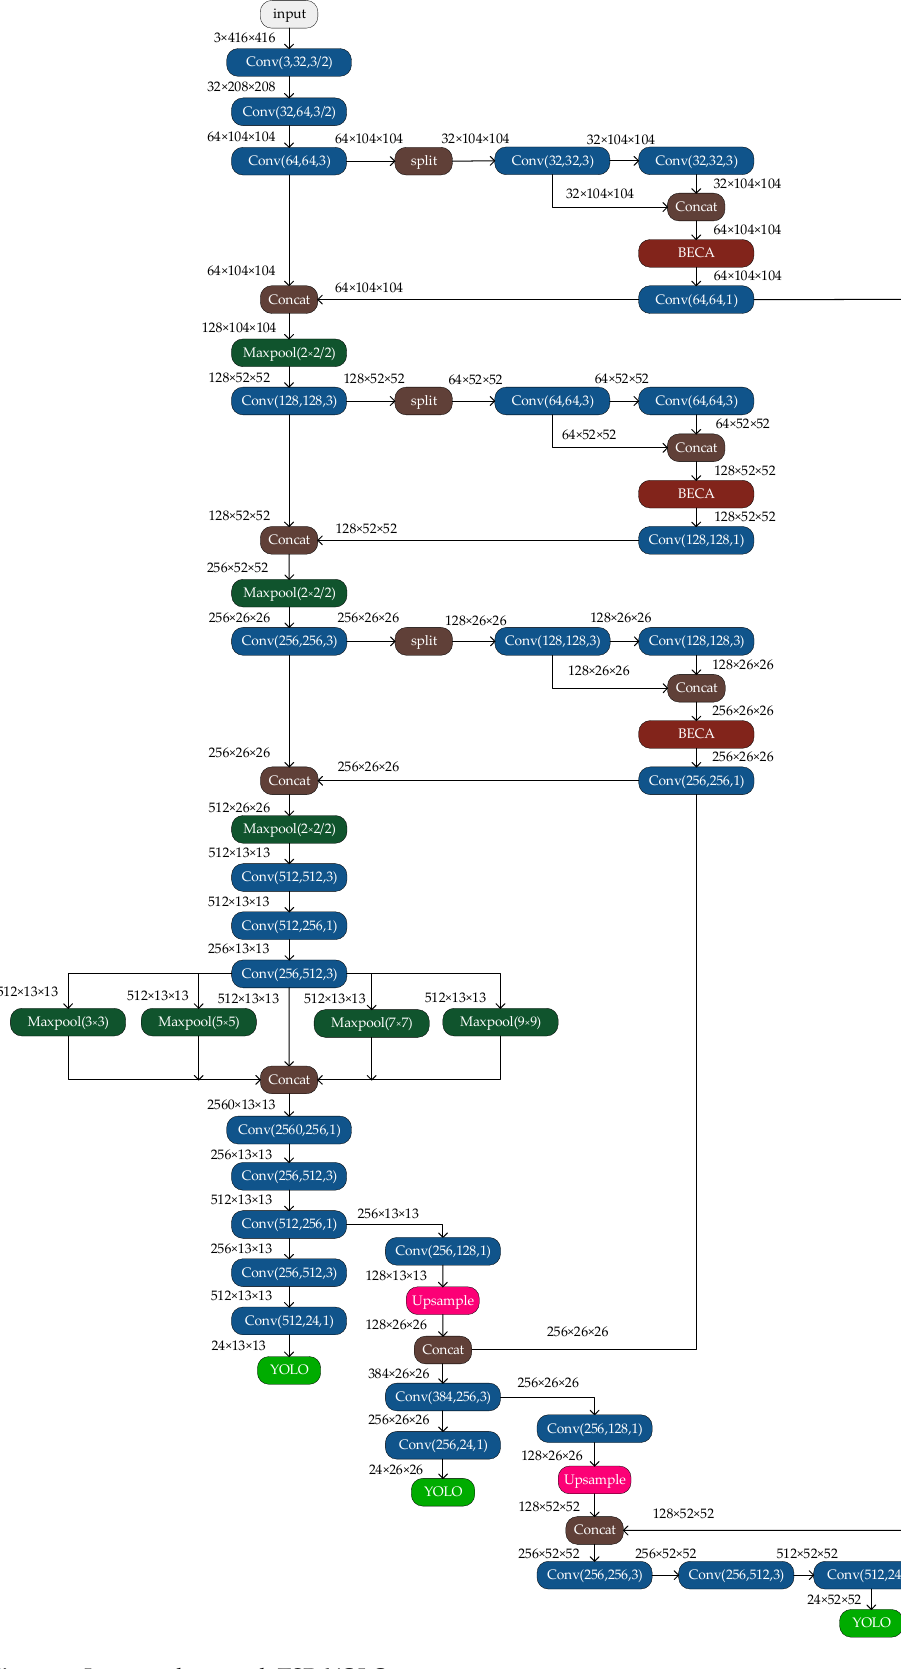
Figure 6. Improved network